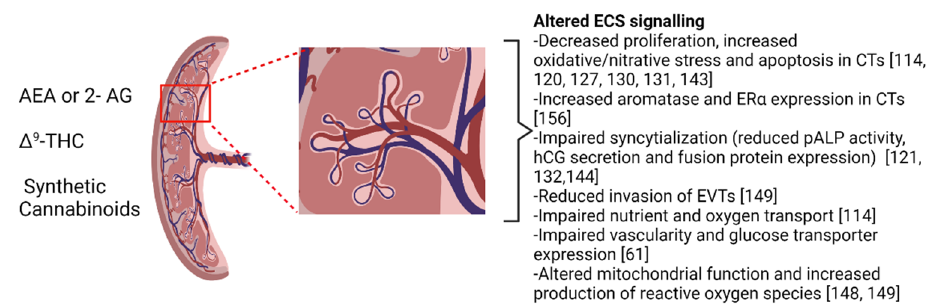
Figure 2. Cannabinoid’s impact signaling in the placenta . The reported effects of anandamide (AEA), 2-arachidonoyl glycerol (2-AG), delta-9-tetrahydrocannabinol ( ∆ 9 -THC) and synthetic cannabinoid agonists have demonstrated that endocannabinoid system (ECS) signaling impacts a broad range of cellular functions within the placenta including estrogen receptor alpha (ER α ) expression, placental alkaline phosphatase (pALP) activity and human chorionic gonadotropin (hCG) secretion in cytotrophoblasts (CT) or extravillous trophoblasts (EVT). The magnified inset illustrates a single spiral artery assembly around which the maternal-fetal interface is constructed. Many of the changes outlined in this figure occur at the maternal fetal interface. Greater details about these studies can be found in the body of this review. This figure was created using BioRender.com accessed on 5 August